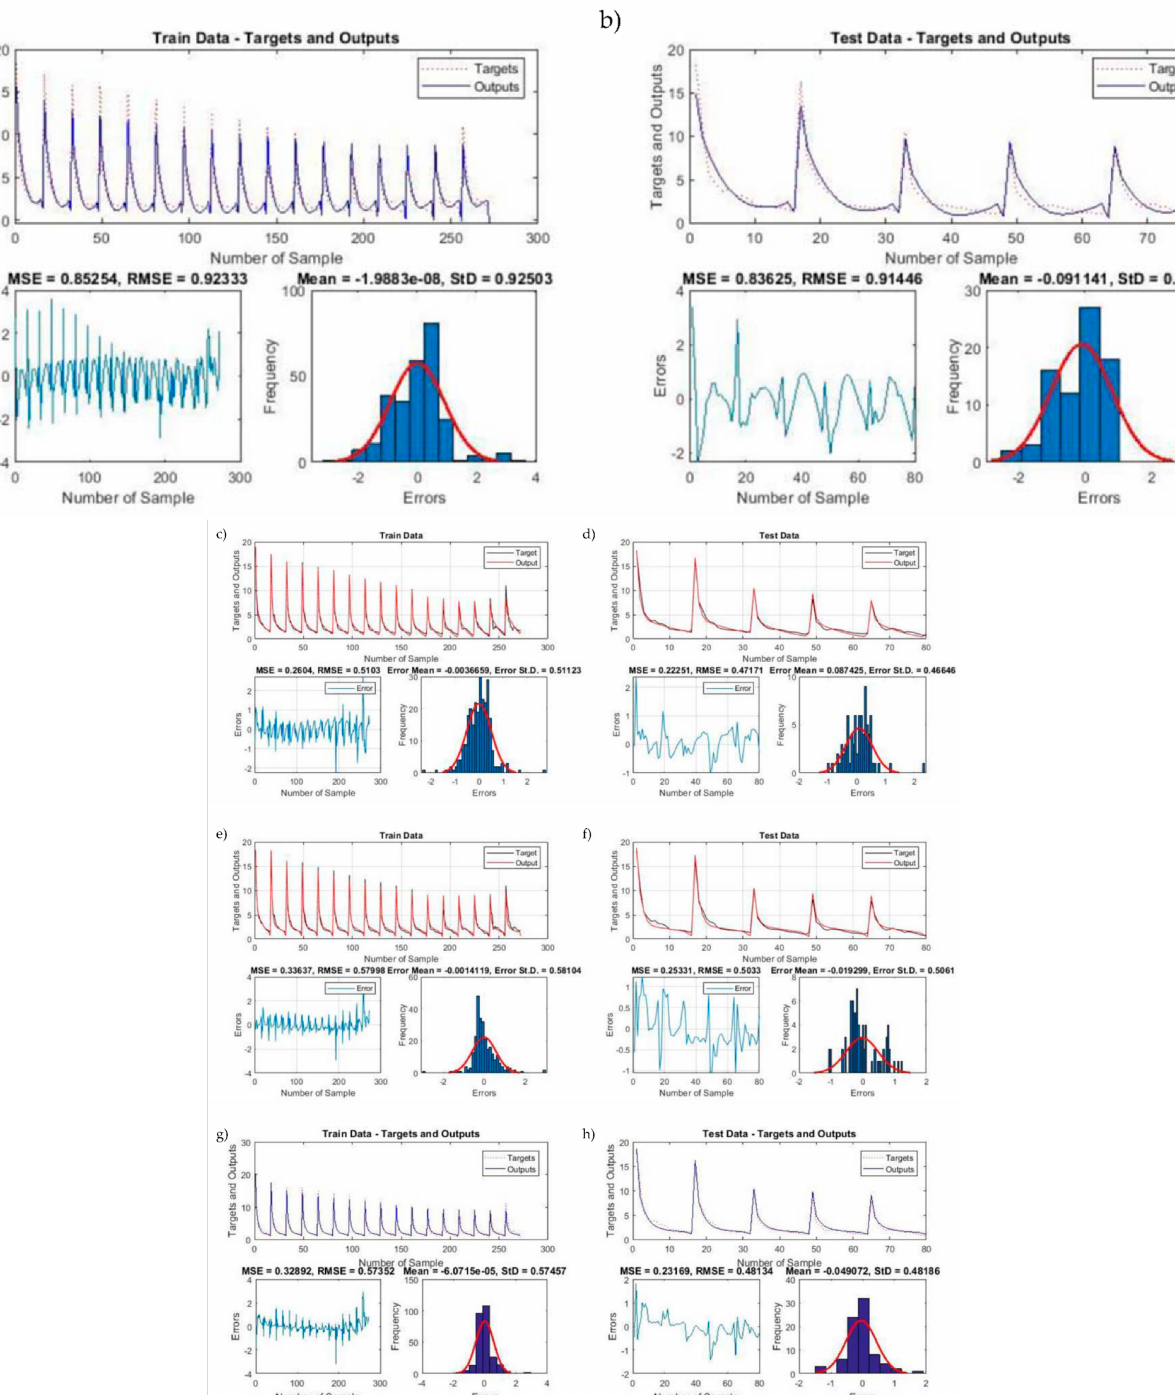
Figure 7. For output S m , ANFIS Model ( a ) targets and outputs, RMSE, MSE values and frequency vs. errors graphs for train data set ( b ) targets and outputs, RMSE, MSE values and frequency vs. errors graphs for test data set. ANFIS-GA: ( c ) targets and outputs, RMSE, MSE values and frequency vs. errors graphs for train data set ( d ) targets and outputs, RMSE, MSE values, and frequency vs. errors graphs for test data set. ANFIS-PSO: ( e ) targets and outputs, RMSE, MSE values and frequency vs. errors for train data set ( f ) targets and outputs, RMSE, MSE values, and frequency vs. errors for test data set. ANFIS-FFA: ( g ) targets and outputs, RMSE, MSE values and frequency vs. errors for train data set ( h ) targets and outputs, RMSE, MSE values, and frequency vs. errors for test data